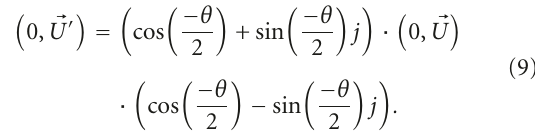
From Q 1 , we calculated in (9) the intermediate coordi- (cid:2) nates U (cid:4) = ( x (cid:4) , y (cid:4) , t (cid:4) ) using the definition given in